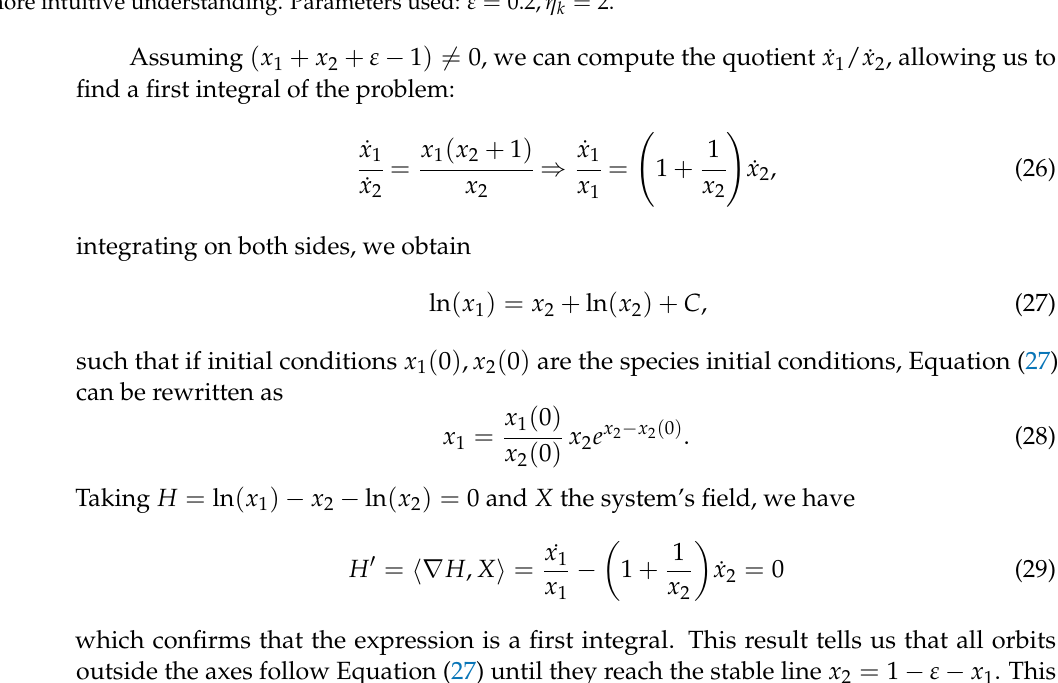
as a function of ε 12 and β plotted as a surface ( a ) and as a 1